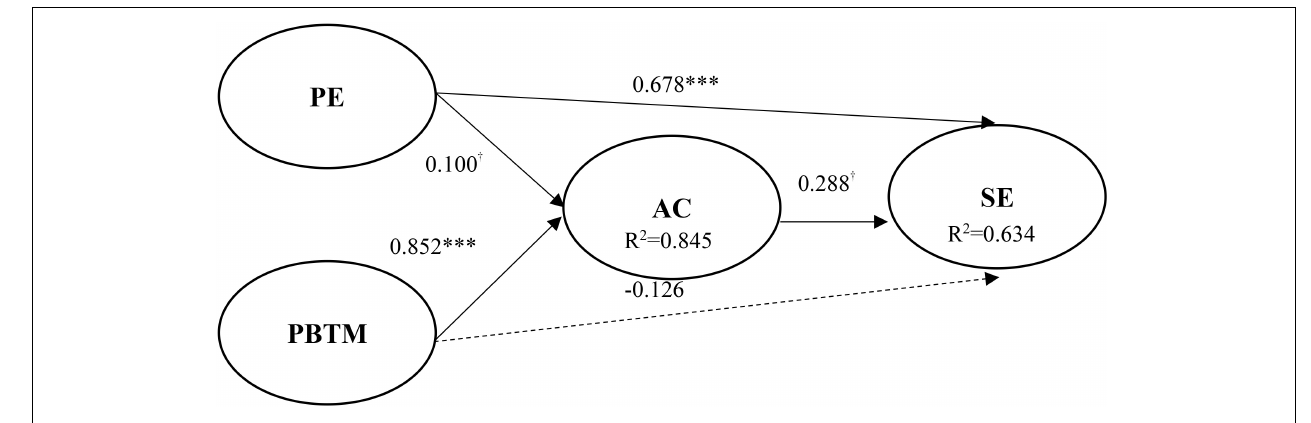
FIGURE 2 | Path analysis. *** p < 0 . 001; †